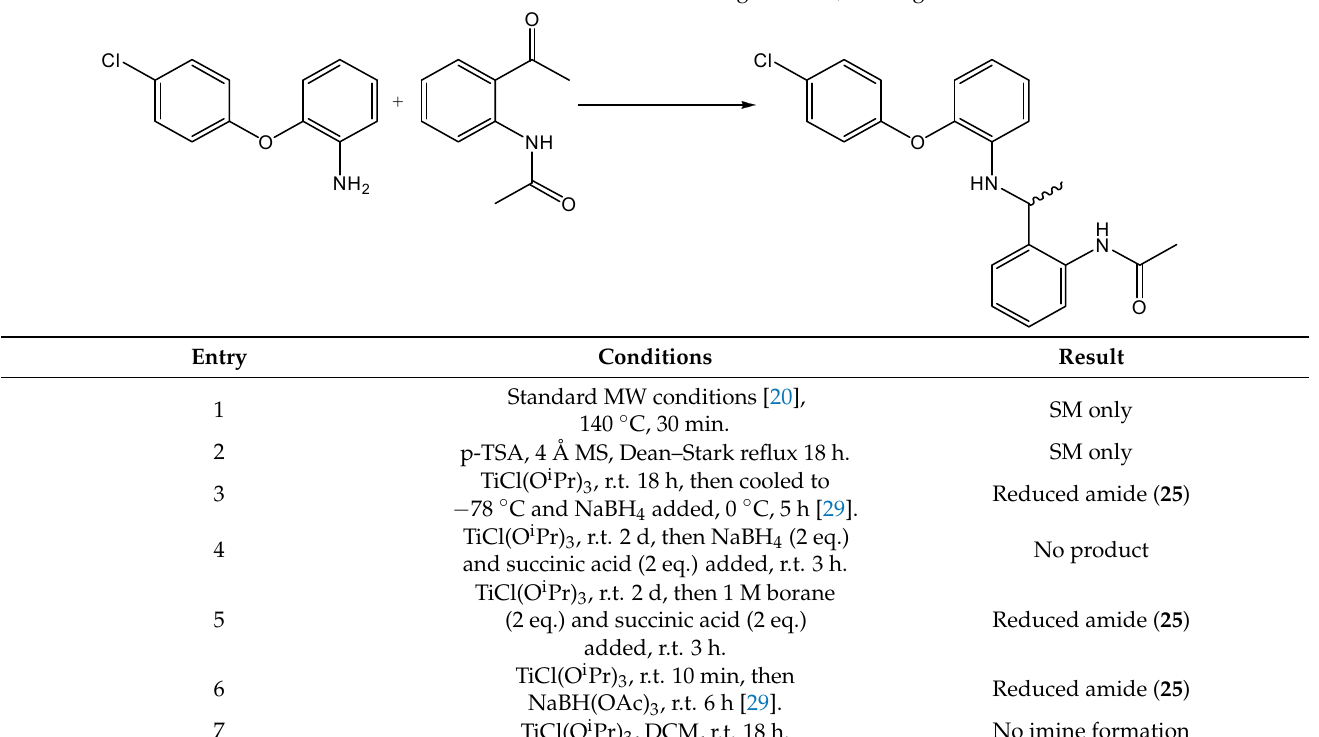
group. Attempts to control this reaction, by using different reagents or temperatures, were the reduced amide as before ( 25 , Entries 4–6). Table 5. Reductive amination conditions investigated. SM, starting material. Table 5. Reductive amination conditions investigated. SM, starting material.